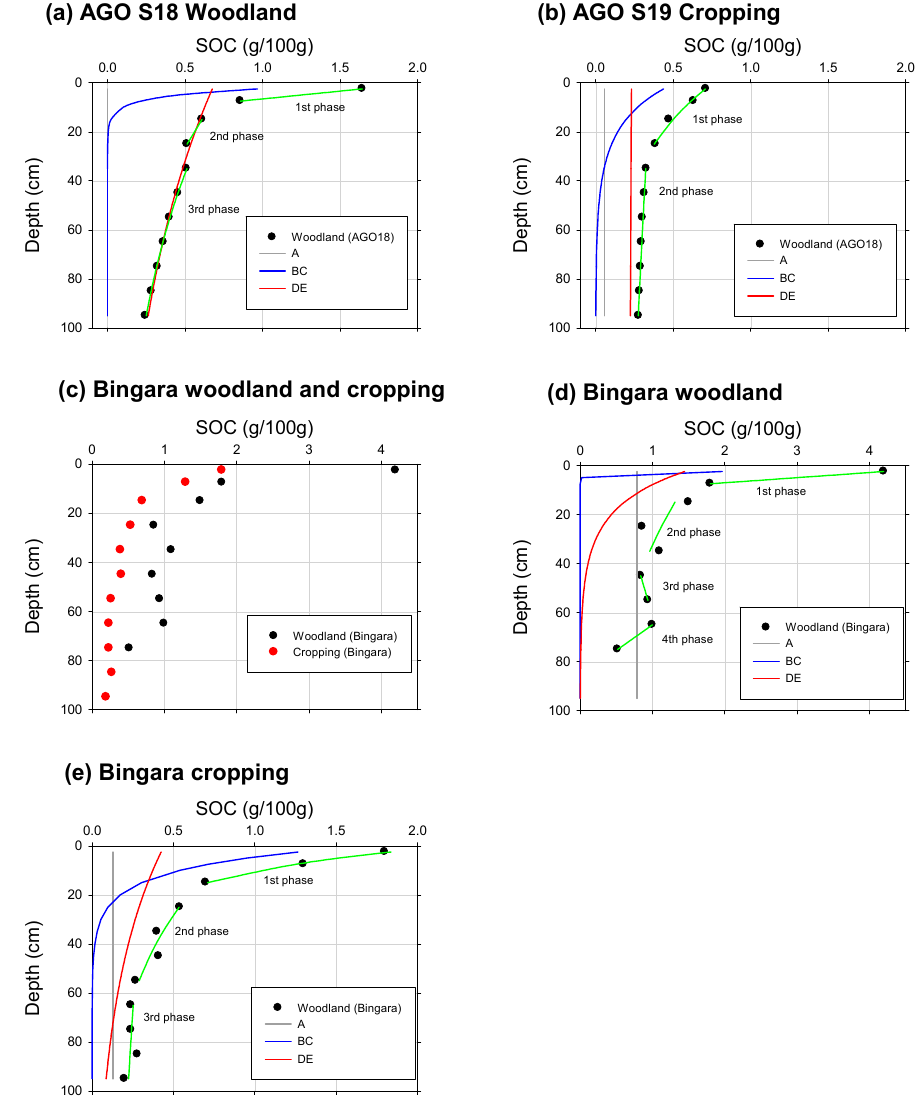
Figure 7. Comparison of two-phase exponential functions and semi-log functions for di ff erent land uses. Two-phase function SOC = A + B exp (zC) + D exp (zE). Phases derived subjectively from inspection of scatterplots for semi-log functions are labelled. Comparison for paired sites ( a ) AGO 18 woodland, ( b ) AGO 19 cropping, ( c ) observed data from Bingara metasediments woodland and cropping, ( d ) semi-log plots for Bingara woodland and ( e ) Bingara cropping. Green line shows the actual measured data.